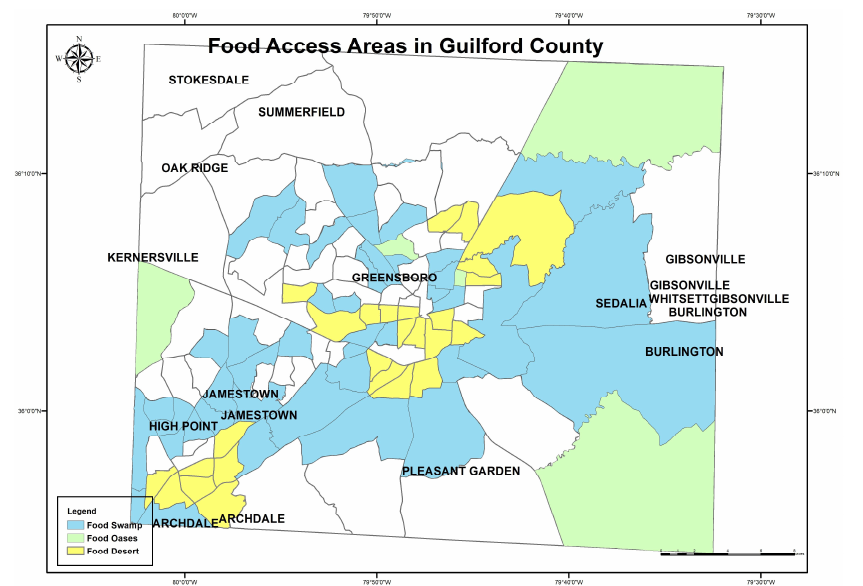
Figure 8. . Figure 8. Geospatial map of food access in Guilford